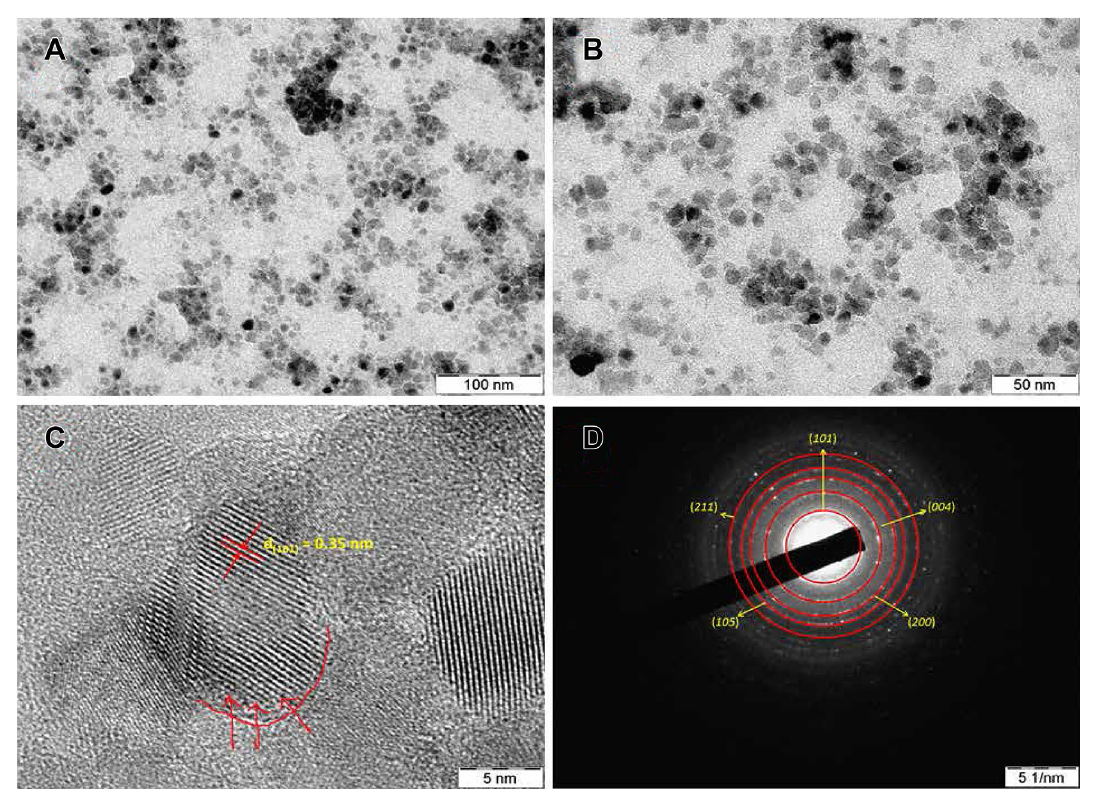
Fig. 5 TEM images ( a , b ), HRTEM image ( c ) and SAED patterns ( d ) of the B-TiO